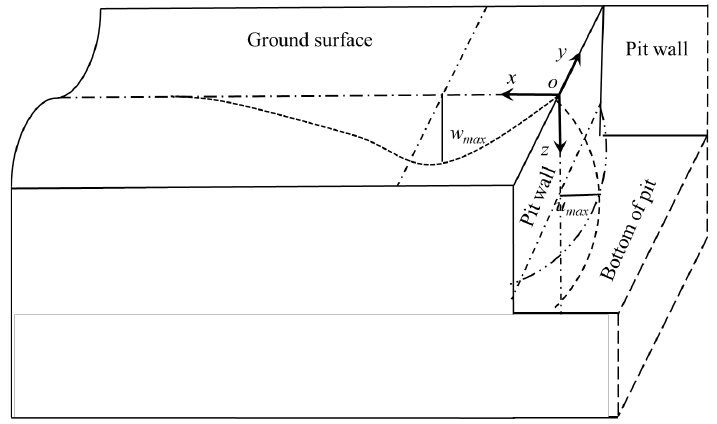
Figure 5. Schematic diagram of deformations of wall and soils induced by excavation.